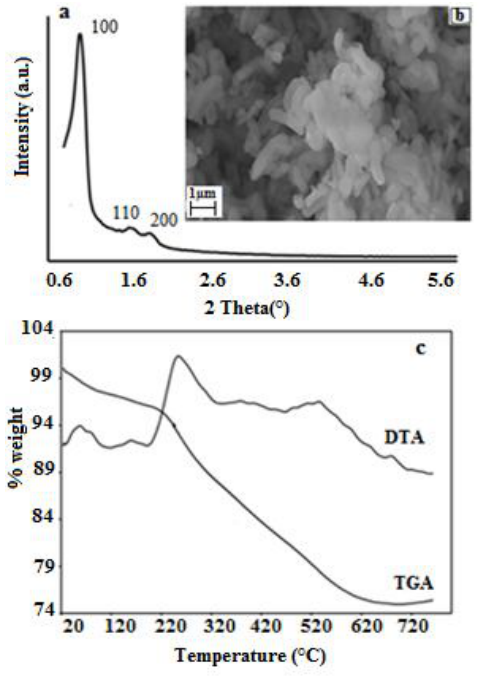
Fig. 1. (a) Low angle XRD pattern, (b) SEM image (c) TGA and DTA diagrams of BSEA- SBA-15.